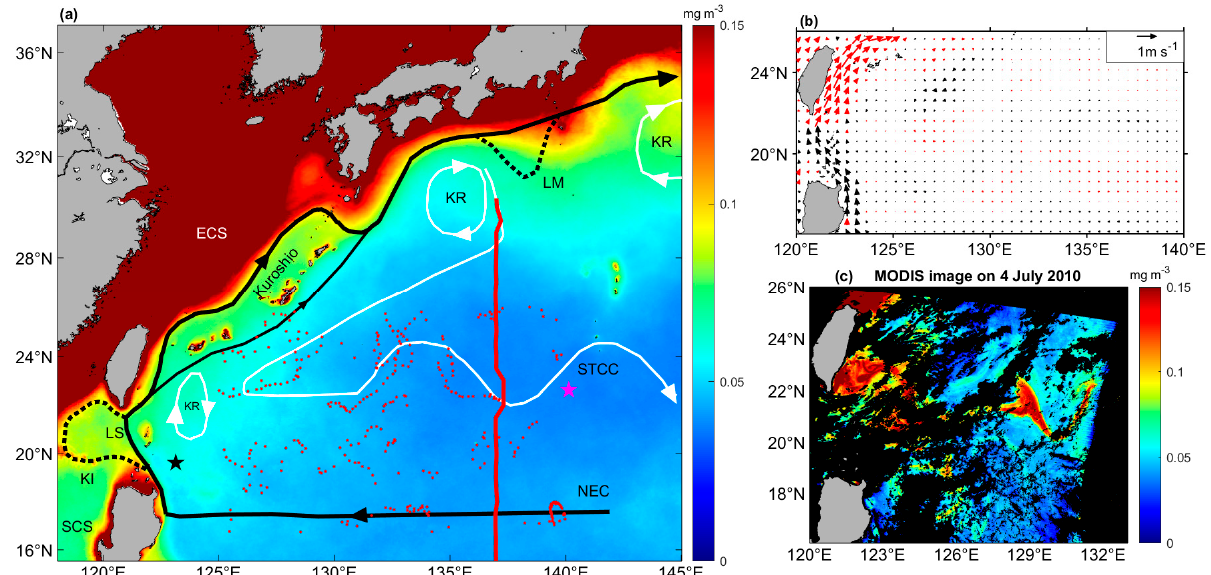
Figure 1. ( a ) Schematic of the Kuroshio Current (KC) circulation system [1,8,20] superimposed on the climatology 1/24°-gridded chlorophyll-a (Chl-a; color shaded) in July from 1998 to 2020. The black bold solid line with arrows shows the flow of the KC and its connection with the North Equatorial Current (NEC). The white circles show the clockwise Kuroshio recirculation (KR) near Japan [1] and Taiwan [8]. The white wave-pattern curve near 22° N indicates the eastward-flowing Subtropical Countercurrent (STCC) [6]. The black dashed curves show the large meandering (LM) of KC south of Japan [1] and the loop of Kuroshio intrusion (KI) via the Luzon Strait (LS) into the South China Sea (SCS) [21]. The meridional red bold line denotes the 137° E transect. The red dots show the locations of the Argo profiles used in this study. Black and magenta stars show the locations of background water masses near the KC and the STCC, respectively; ( b ) climatology of 1/4°-gridded geostrophic flow in July from 1998 to 2020 with red arrows indicating positive zonal velocities and black arrows indicating negative zonal velocities; ( c ) Aqua-MODIS Level 2 Chl-a image at 1 km spatial resolution taken on 4 July 2010.